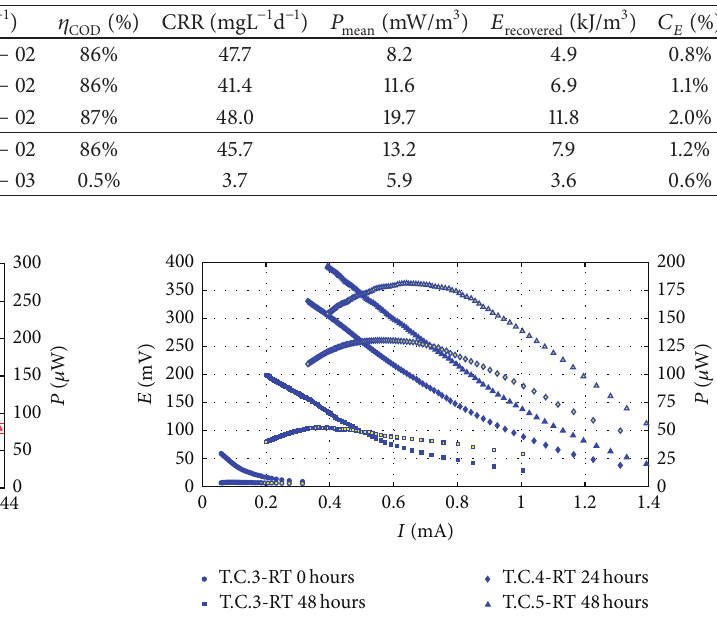
Figure 5: Anodic biomass growing throughout three consecutive treatment cycles with SW2, without emptying the cell. Filled points represent polarization curves, empty points the power